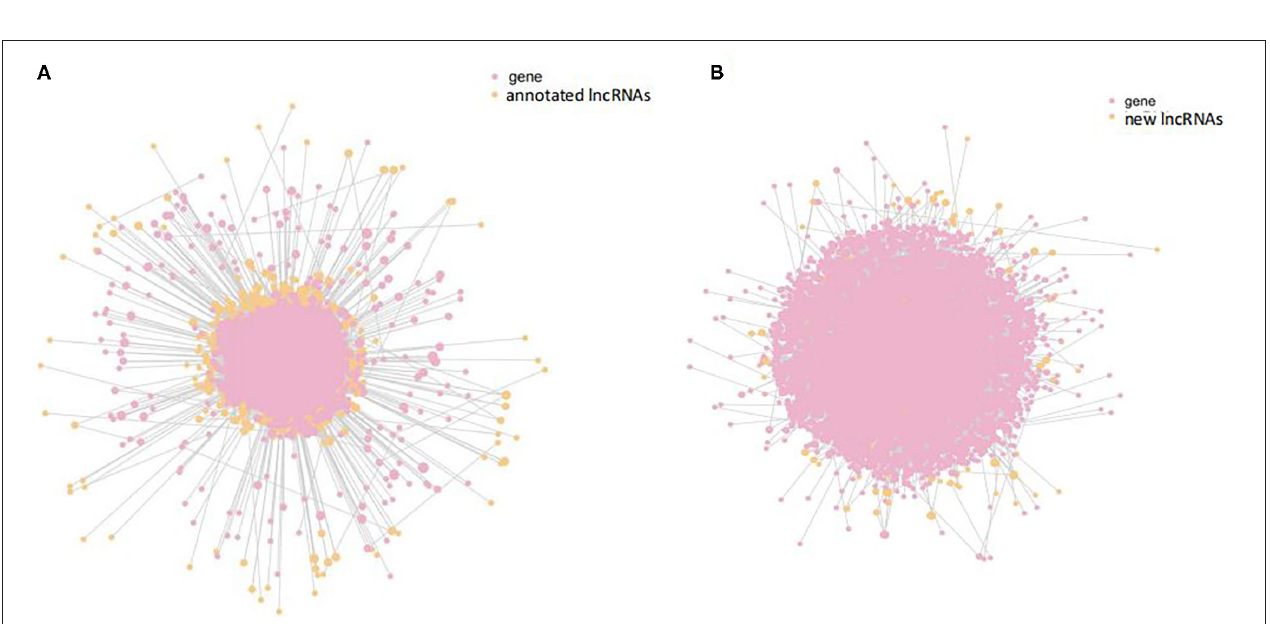
FIGURE 5 | Interaction analysis of differentially expressed annotated lncRNAs and target genes. (A) Interaction analysis of differentially expressed annotated lncRNAs (orange) and target genes (pink). (B) Interaction analysis of differentially expressed new lncRNAs (orange) and target genes (pink).